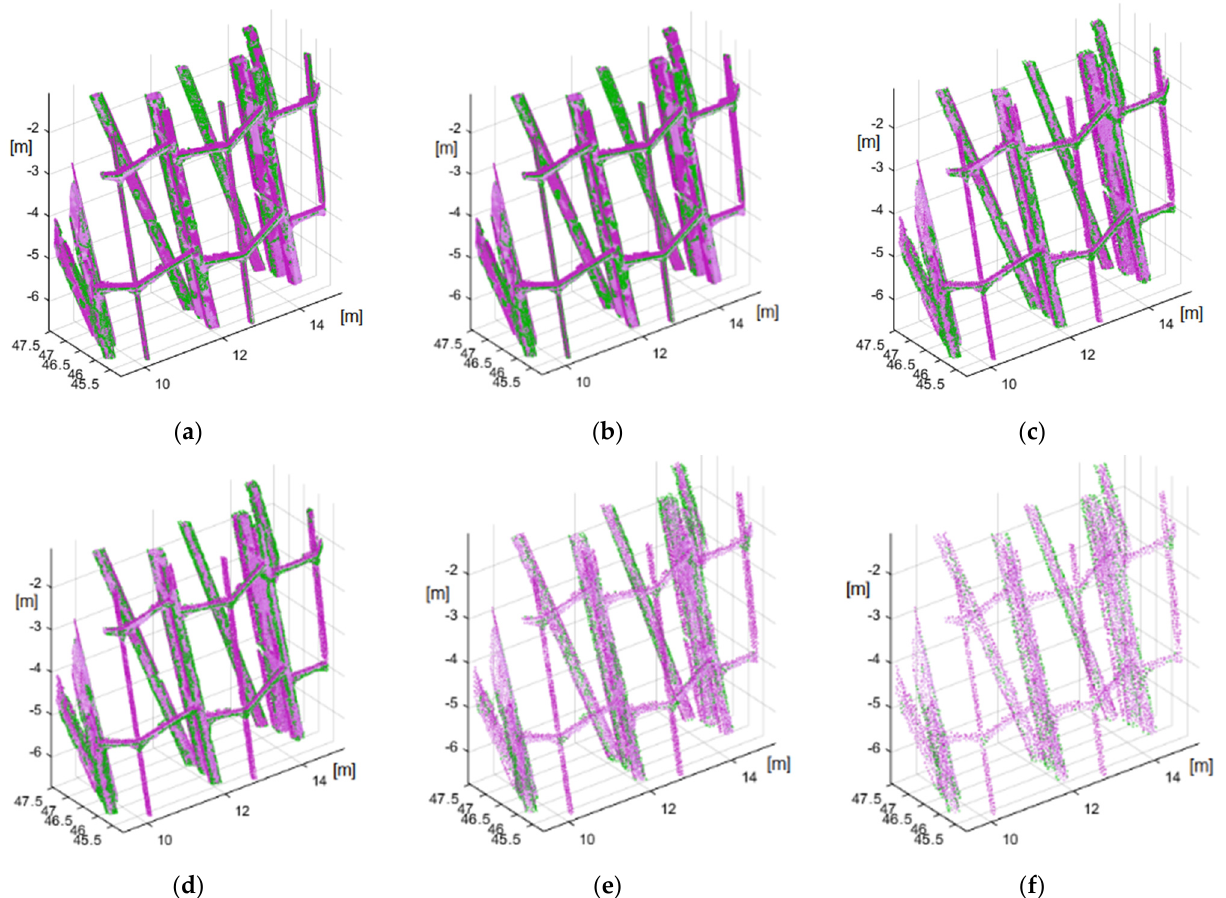
Figure 14. Results for a set of reduced data: ( a ) no reduction, ( b ) 0.5 mm, ( c ) 1 mm, ( d ) 3 mm, ( e ) 5 mm, ( f ) 7 mm (magenta: source points; green: edges detected).